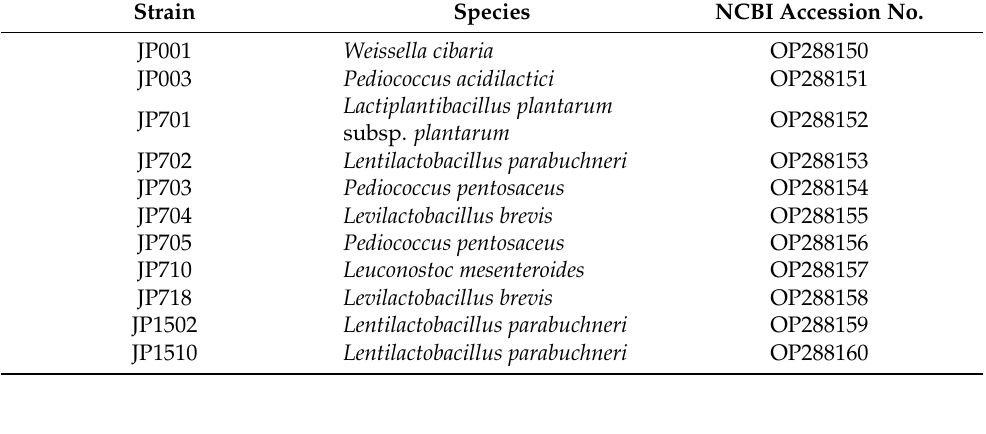
Table 9. Identification of 11 isolates by 16S rRNA gene sequencing and their accession numbers from GenBank.